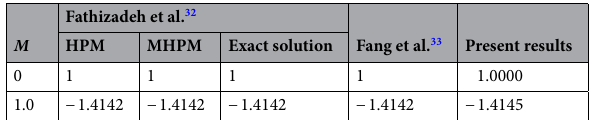
Table 1. The comparative analysis when β = S ∗ = A 1 = A 2 = α = 0.